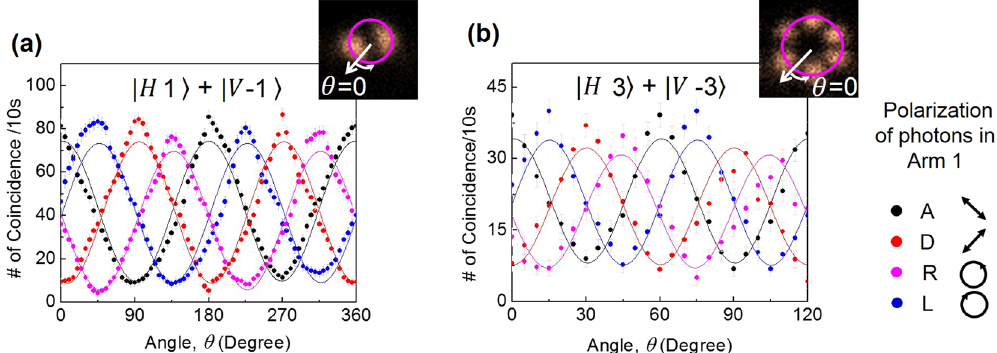
Figure 5. Distribution of heralded signal photon number per angular region. Coincidence per angular region for A (black dots), D (red dots), R (pink dots) and L (blue dots) projections of the idler photon for OAM ( a ) l = 1, and ( b ) l = 3. The lines are theoretical fit to the experimental data. (Inset) Image of the probability distribution of the heralded signal photons. Errors are estimated from